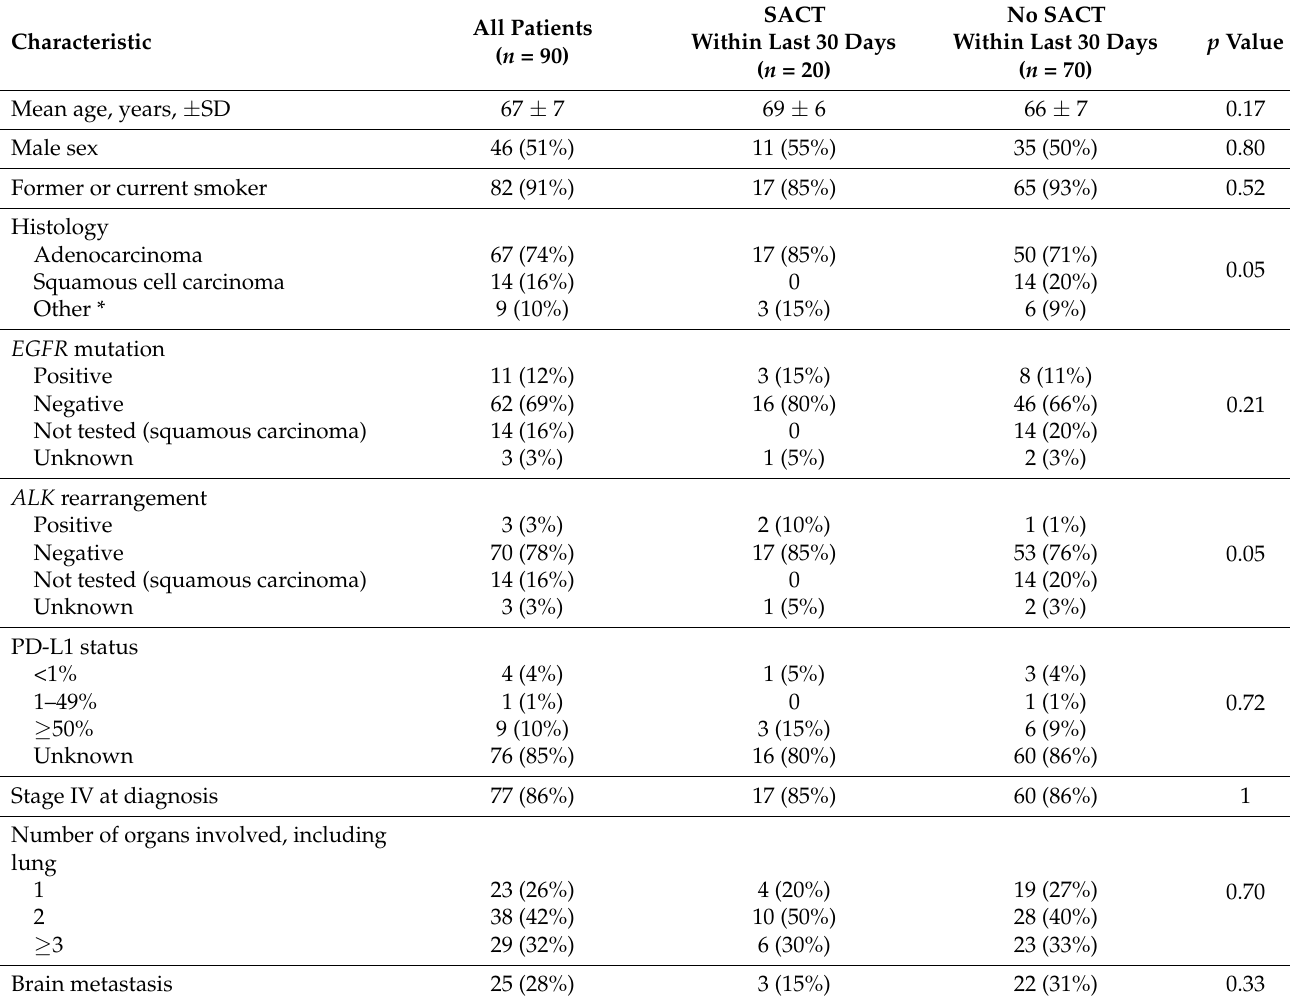
Table 1. Baseline patient characteristics and